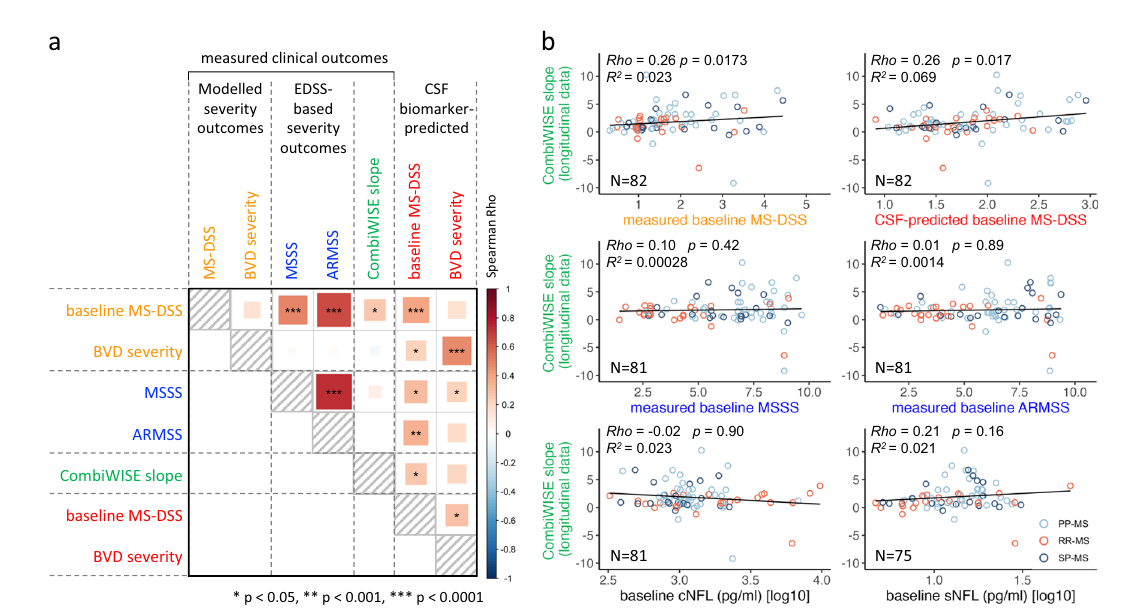
Fig. 7 | MS severity outcomes in the validation cohort and their associations with cerebrospinal fl uid (CSF) model predictions. a Spearman correlation (the size and color of the square represent the Spearman Rho; signi fi cance levels are depicted by stars) between fi ve measured clinical outcomes and two CSF bio- marker-predicted multiple sclerosis (MS) severity outcomes in the validation cohort ( N =98). b Correlations between prospectively measured MS progression slopes (i.e., therapy adjusted CombiWISE slopes derived from longitudinal clinical